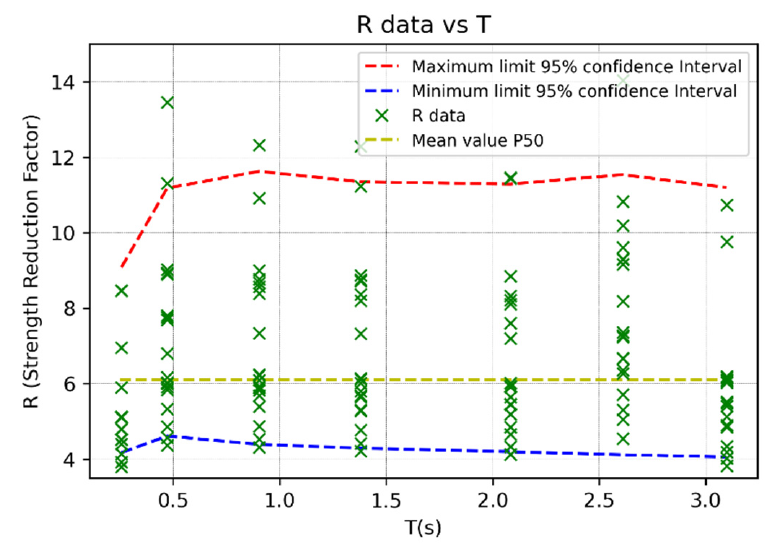
Figure 12. Maximum and minimum limits of the confidence interval.